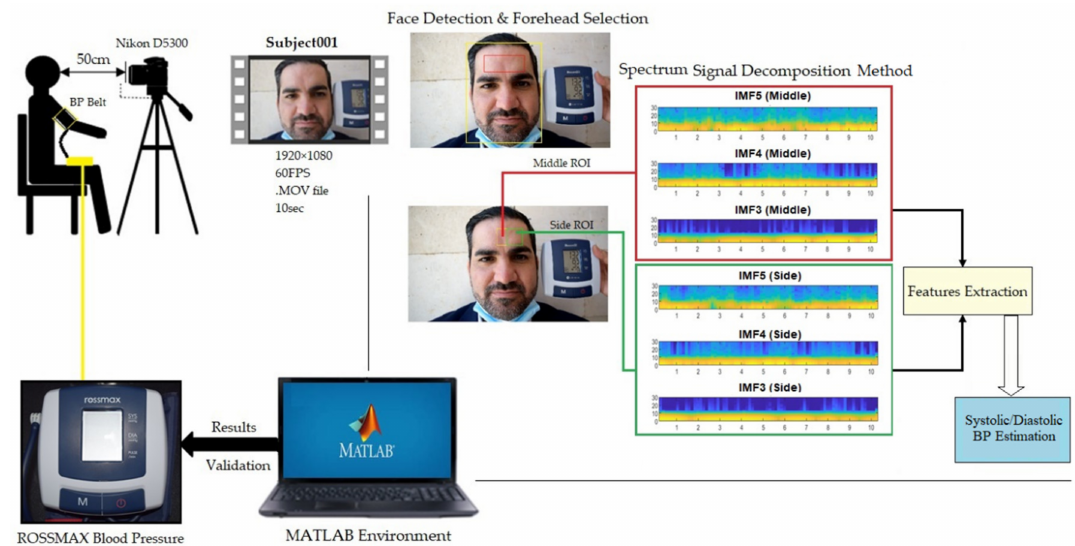
Figure 1. Demonstrating the proposed imaging system that recorded videos by a digital camera and processed the obtained signals while simultaneously recording the BP readings from a contact pressure cuff device for validation purposes.